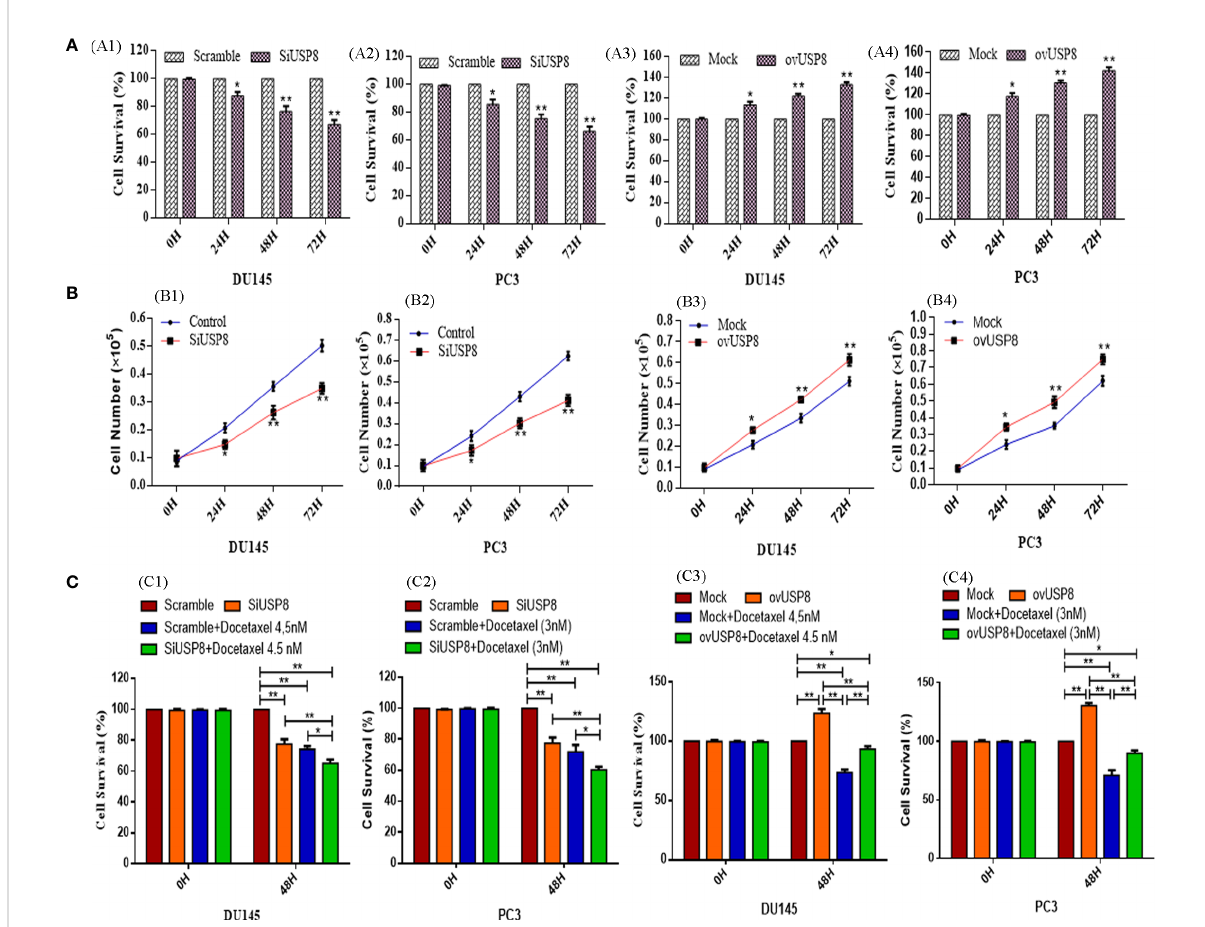
FIGURE 1 USP8 regulates PCa cell growth and proliferation. (A) DU145 and PC3 cell lines were transiently transfected with scramble siRNA, siUSP8, a mock vector, and a USP8-overexpressing vector. The MTT assay was used to determine cell survival at a different time point (0, 24, 48, 72 h). (B) Growth curves of DU145 and PC3 PCa cell lines. DU145 and PC3 PCa cells were transfected with scramble siRNA, siUSP8, a mock vector, and a USP8- overexpressing vector. Cells were cultured with a density of 1 × 10 5 cells/ml. At the same time points, a total number of Trypan Blue-negative cells were manually counted and displayed. (C) DU145 and PC3 cells were transfected with scrambled siRNA or SiUSP8, and mock or USP8- overexpressing vector followed by docetaxel therapy with 4.5 and 3 nM, respectively. After 48 h, the cells were subjected to MTT assay and the cell survival from optical density (OD) calculated. The OD was set to 490 nm, and all data are presented as mean ± SD (n = 3, * p < 0.05 and ** p <